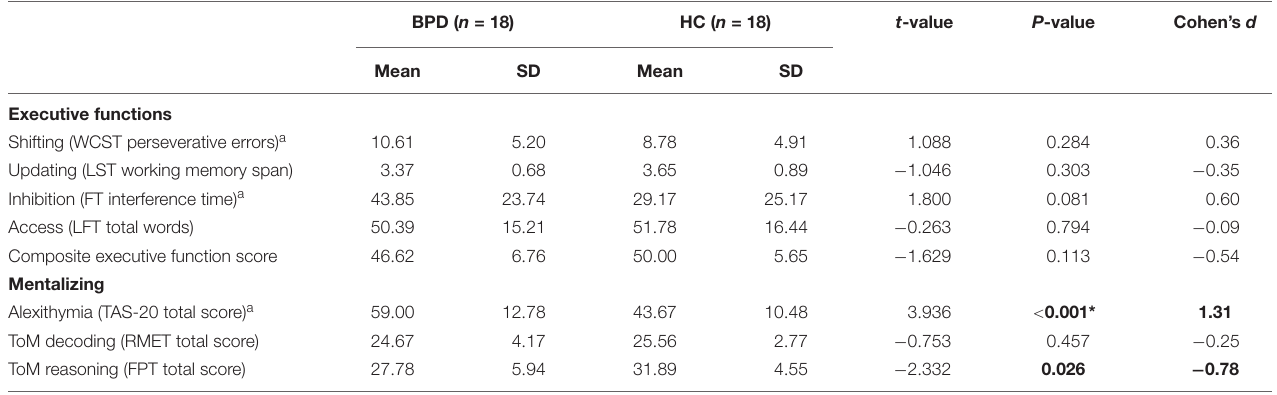
TABLE 2 | Executive functions and mentalizing abilities in patients with borderline personality disorder (BPD) and healthy control (HC). BPD ( n = 18) HC ( n = 18) t -value P -value Cohen’s d Mean SD Mean SD